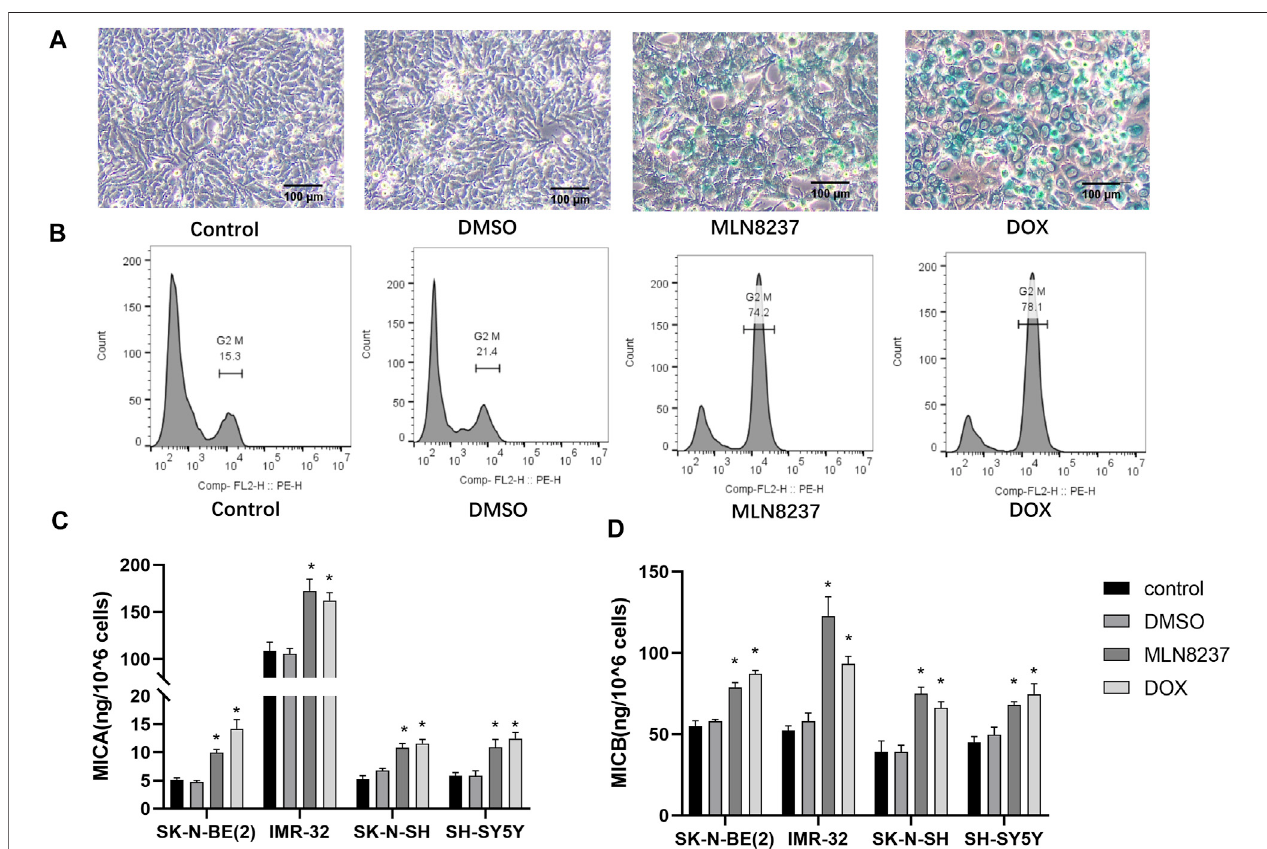
FIGURE 1 | MICA/B release is increased from senescent cells. (A) SH-SY5Y cells were treated with 2 μ M MLN8237, 0.5 μ M DOX, DMSO, or no treatment as a control, and after 72 h, cellular senescence was evaluated by SA- β -gal staining. Senescent cells are shown by blue staining (magni fi cation: ×20). (B) Cell cycle progression was assessed by fl ow cytometry. (C) Four different neuroblastoma cell lines were treated with 2 μ M MLN8237, 0.5 μ M DOX, DMSO, or no treatment as a control, and after 72 h, (D) MICA and MICB concentrations in the supernatant were evaluated by ELISA. Data represent the mean ± SEM of three independent experiments. * p <